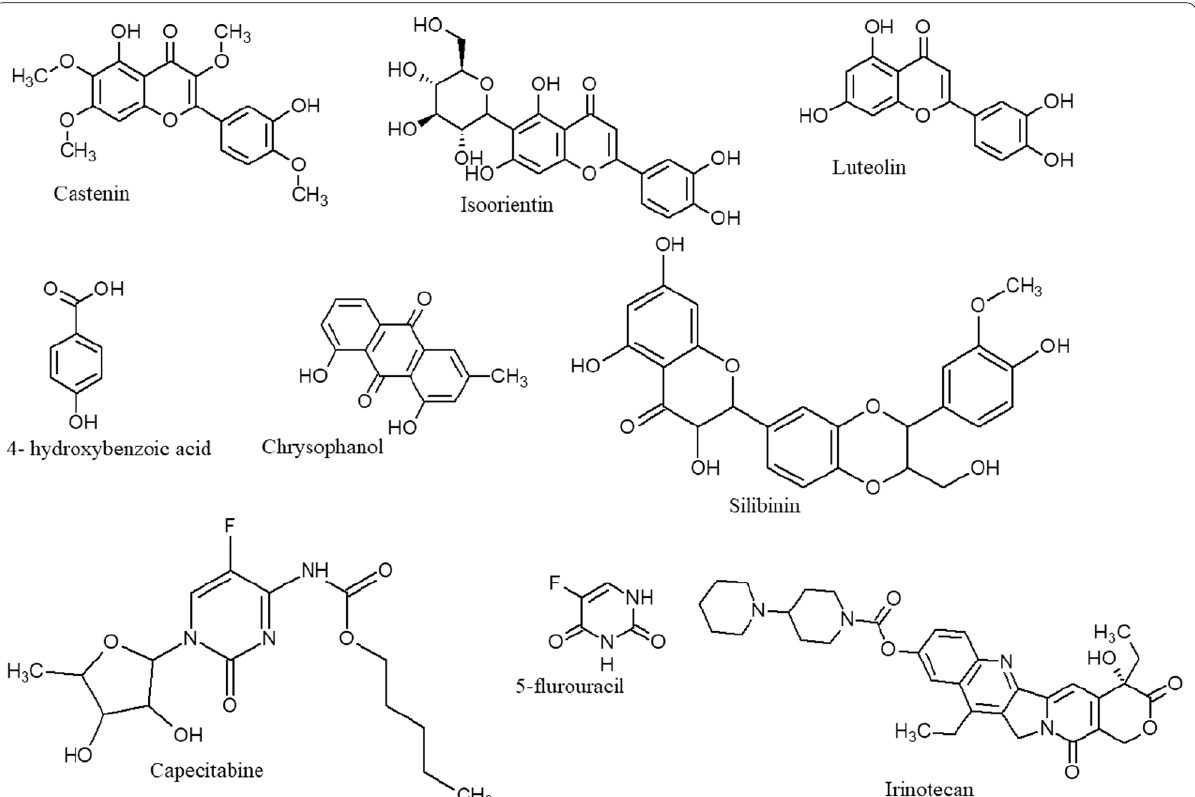
Fig. 1 Representation of phytochemicals and control drug structures of colorectal cancer